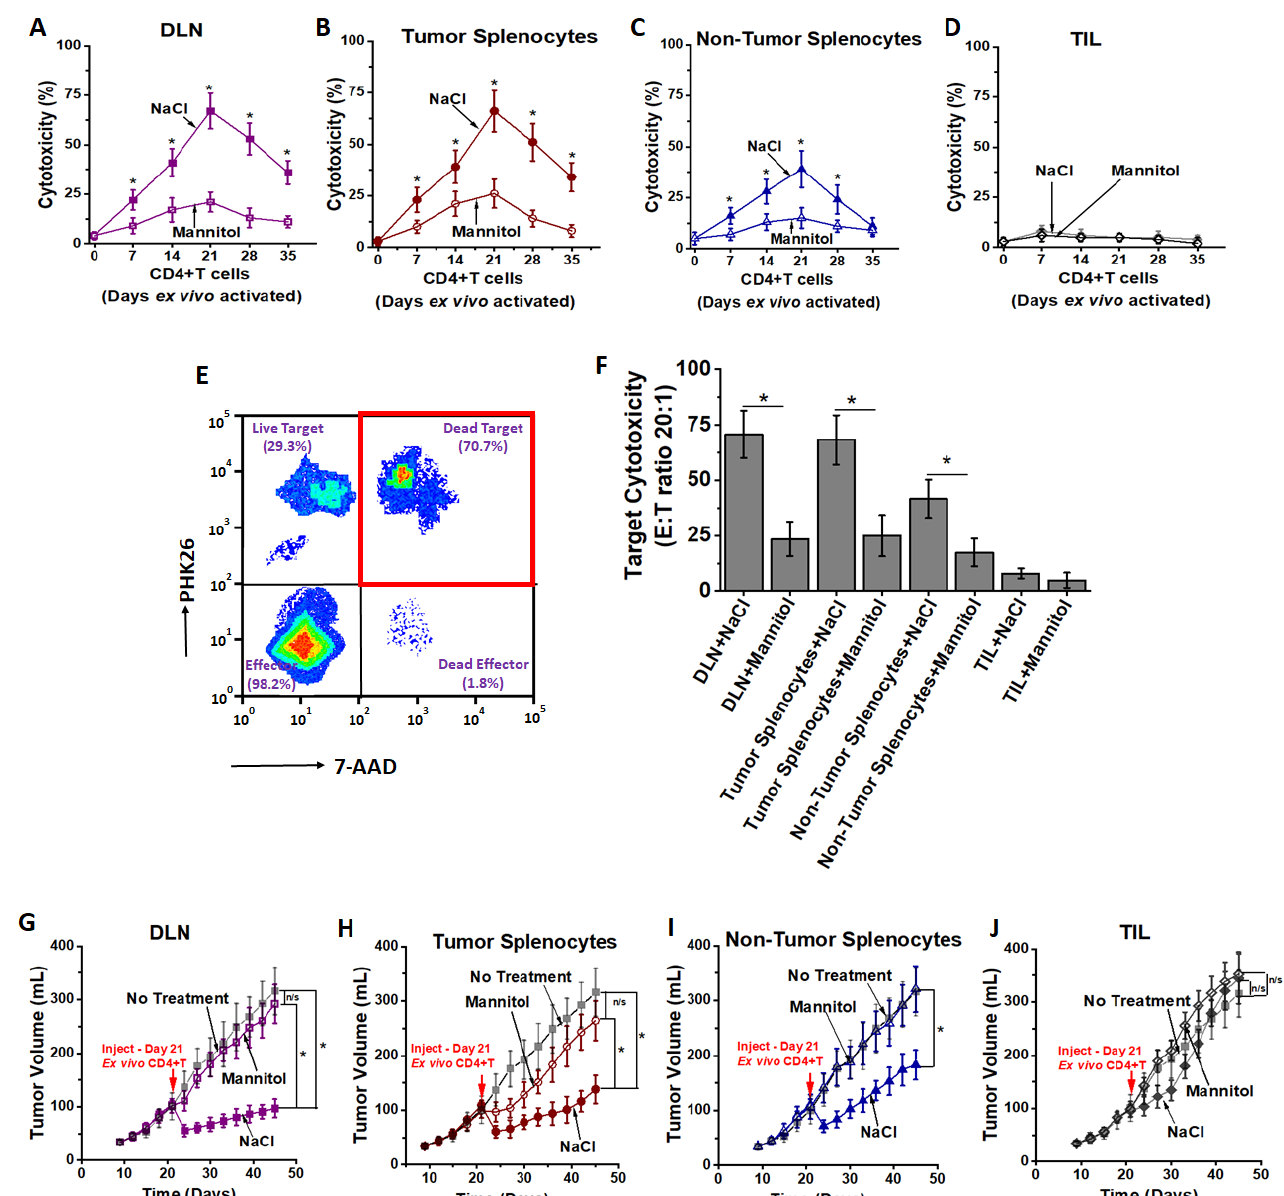
Figure 5. Anti-cancer efficacy of ex vivo expanded CD4+T cells. ( A – C ) Cytotoxic efficiency of CD4+T cells obtained from DLNs ( A ), tumor splenocytes ( B ), non-tumor splenocytes ( C ) and TILs ( D ) following high salt (filled symbols) and equimolar mannitol (open symbols) treatment for five stimulation cycles (up to day 35) tested on Py230 breast cancer cells at effector-to-target (E:T) ratio of 20:1 analyzed by LDH release assay. It is to be noted that DLNs, tumor splenocytes and TILs were obtained from tumor-bearing mice day 28 post-injection of Py230 breast cancer cells into C57Bl/6 mice. ( E , F ) Cytotoxicity of target cells was confirmed by staining of target cells with PKH26 and double positive events (PHK26 and 7-AAD) were determined. ( E ) Flow cytometry plot with CD4+T cells obtained from DLNs at the end of third stimulation cycle on Py230 breast cancer cells at E:T ratio of 20:1. ( F ) Changes in the cytotoxic efficiency of CD4+T cells at the end of third stimulation cycle obtained from DLNs, tumor-splenocytes, non-tumor splenocytes and TILs. Data obtained from 5 independent measurements and presented as mean ± SEM; (*) p < 0.05. ( G – J ) In vivo anti-tumor efficacy of ex vivo expanded CD4+T cells obtained from DLNs ( G ), tumor splenocytes ( H ), non-tumor splenocytes ( I ) and TILs ( J ) following high salt (filled symbols) and equimolar mannitol (open symbols); grey line and symbol represent Py230 tumors in C57Bl/6 mice without any treatment. Data represented as mean ± SEM with n = 6 mice in each cohort, p < 0.05. To further determine the in vivo anti-tumor efficiency of ex vivo activated CD4+T cells, we have utilized a Py230 breast cancer cell based orthotopic syngeneic murine model. The CD4+T cells following three ex vivo stimulations were intraperitoneally in- jected into 21 day old tumor bearing mice and followed up until day 45. As shown in